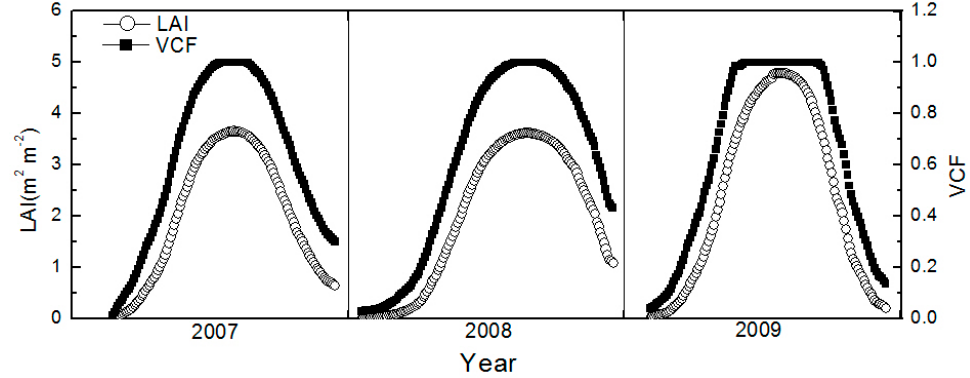
Figure 2. Dynamics of leaf area index (LAI) and vegetation cover fraction (VCF) during 2007–2009.